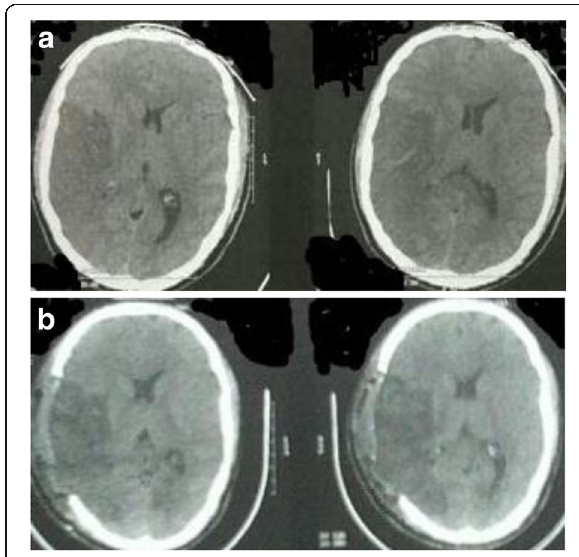
Fig. 2 a 35-year-old male patient with malignant right-sided MCA infarct, preoperative GCS 8/15, and midline shift 6 mm. b Postoperative CT after 3 days showing resolution of midline